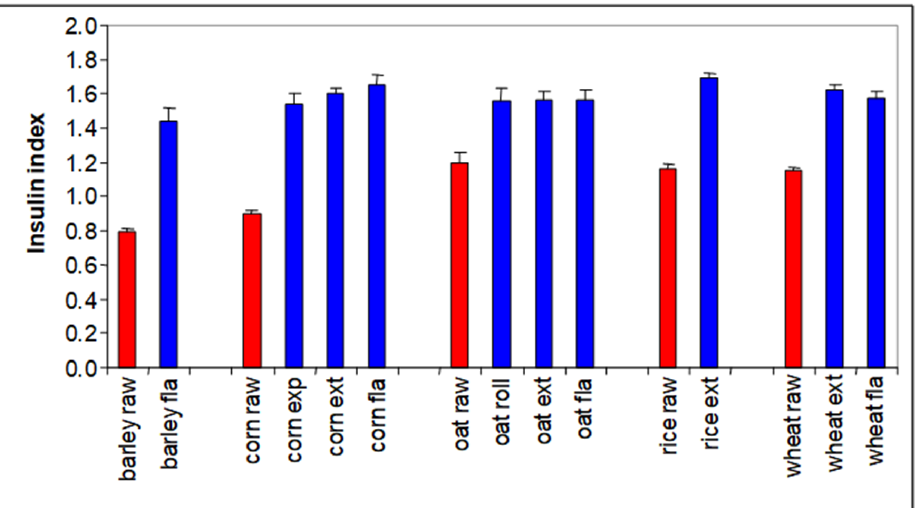
Figure 6. Glycemic response to various cereal and cereal products, as used in swine nutrition (insulin index is the maximal rate of in vitro glucose release/min, which corresponded with the in vivo insulin response) [15,16].